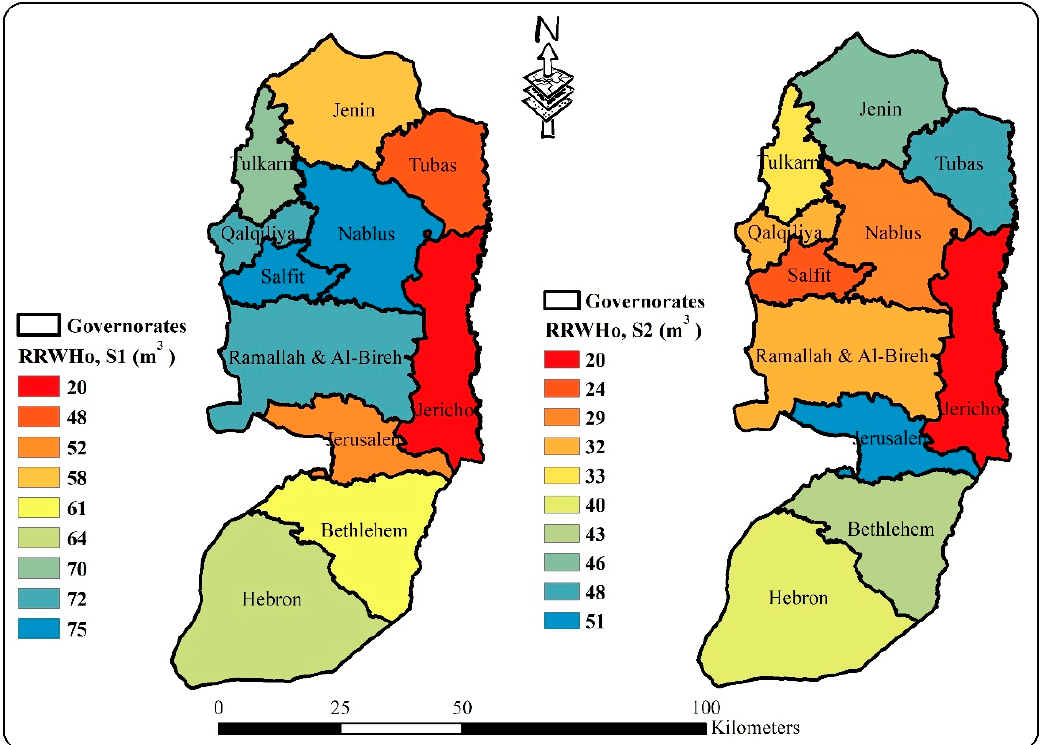
Figure 5. RRWHo tank size for a rooftop area of 150 m 2 for the different West Bank governorates and the S1 and S2 scenarios.